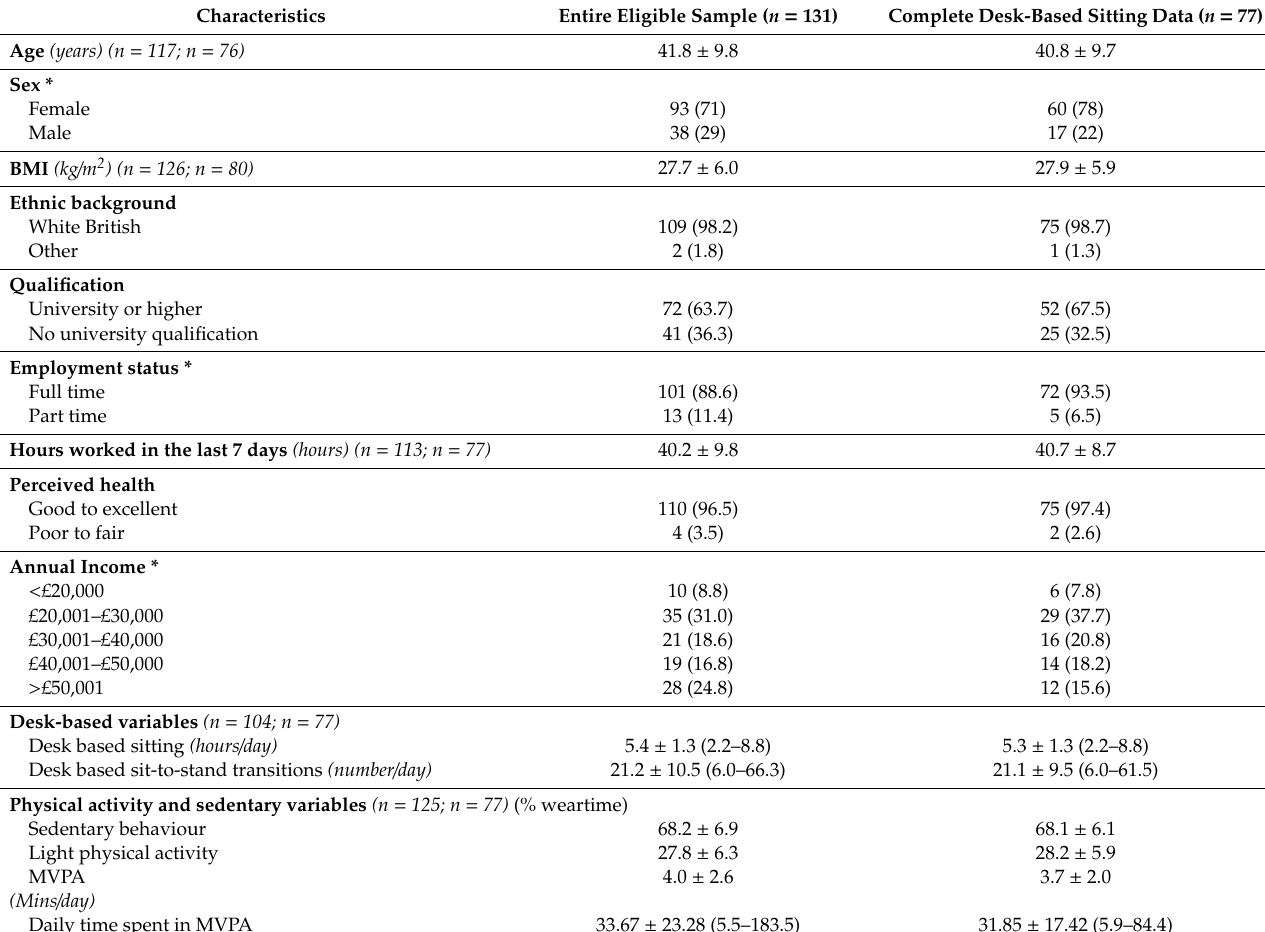
Table 1. Description of the entire eligible sample and analysed sample with complete desk-based sitting pattern